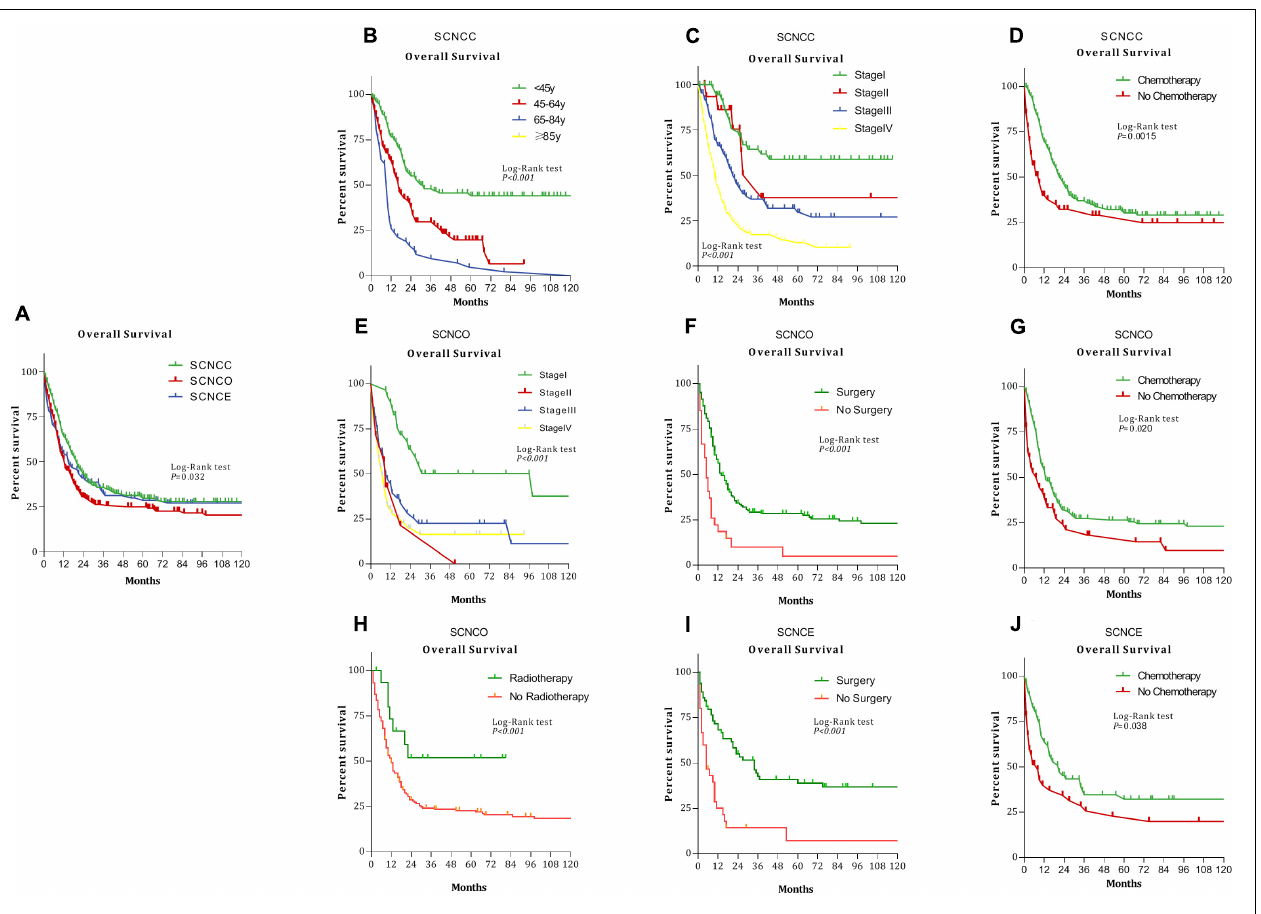
FIGURE 1 | Kaplan–Meier analysis of overall survival among patients with small-cell neuroendocrine carcinoma of the gynecologic tract (SCNCGT) ( P = 0.032) (A) . Small-cell neuroendocrine carcinoma of the cervix (SCNCC) and age ( P < 0.001) (B) . SCNCC and stage ( P < 0.001) (C) . SCNCC and chemotherapy ( P = 0.0015) (D) . Small-cell neuroendocrine carcinoma of the ovary (SCNCO) and stage ( P < 0.001) (E) . SCNCO and surgery ( P = 0.0015) (F) . SCNCO and chemotherapy ( P = 0.020) (G) . SCNCO and radiotherapy ( P < 0.001) (H) . Small-cell neuroendocrine carcinoma of the endometrium (SCNCE) and surgery ( P = 0.0015) (I) . SCNCE and chemotherapy ( P = 0.038) (J)